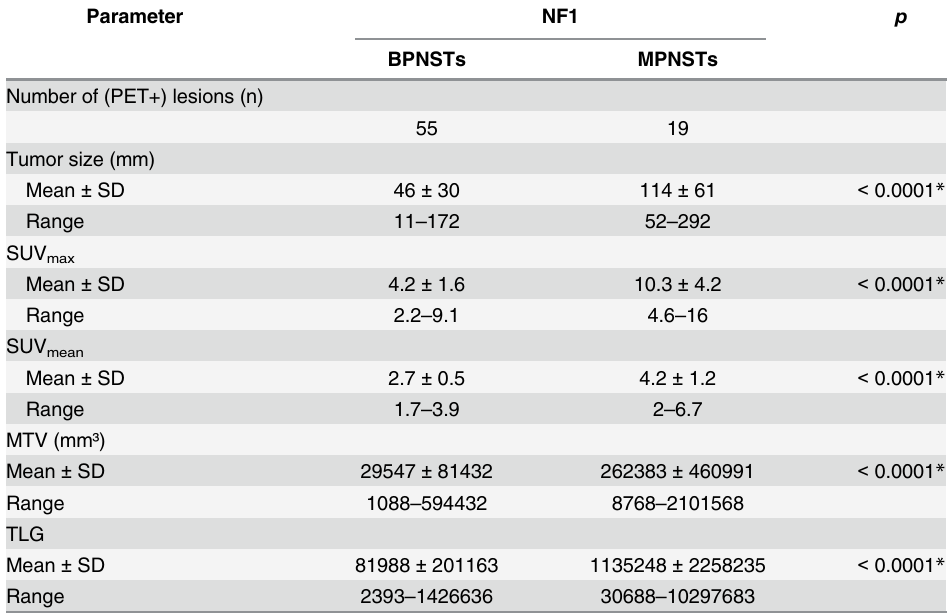
Table 2. Data on imaging-derived parameters of benign and malignant PNSTs at a SUV max threshold of 2.0. Parameter NF1 p BPNSTs